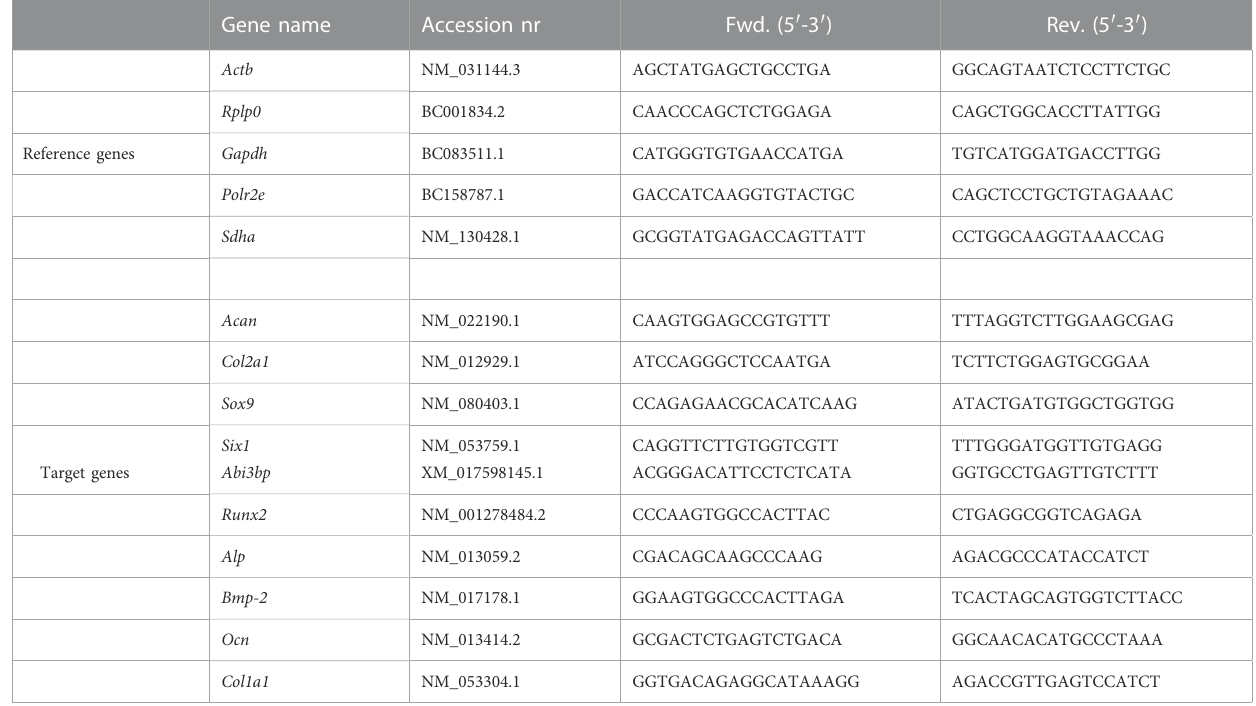
TABLE 2 The target and reference genes